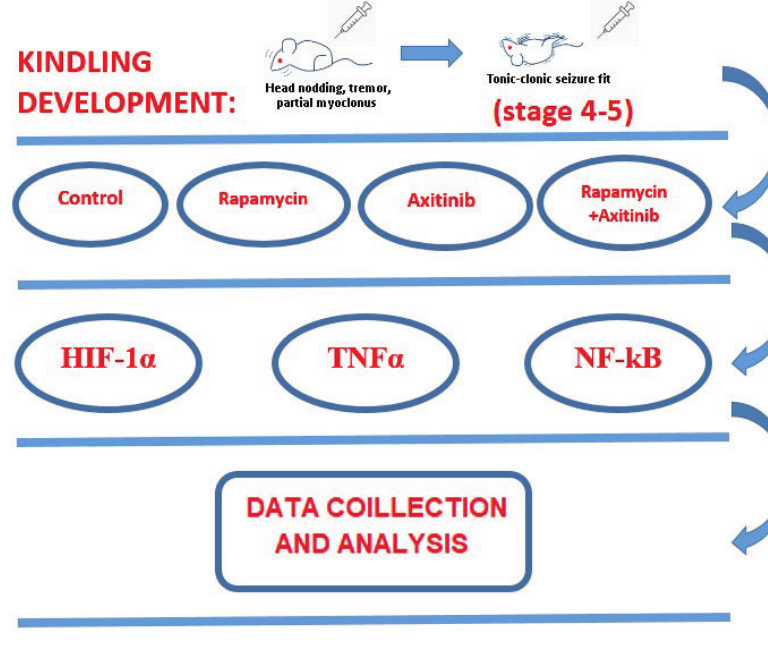
Fig. 1. Algorithm of the